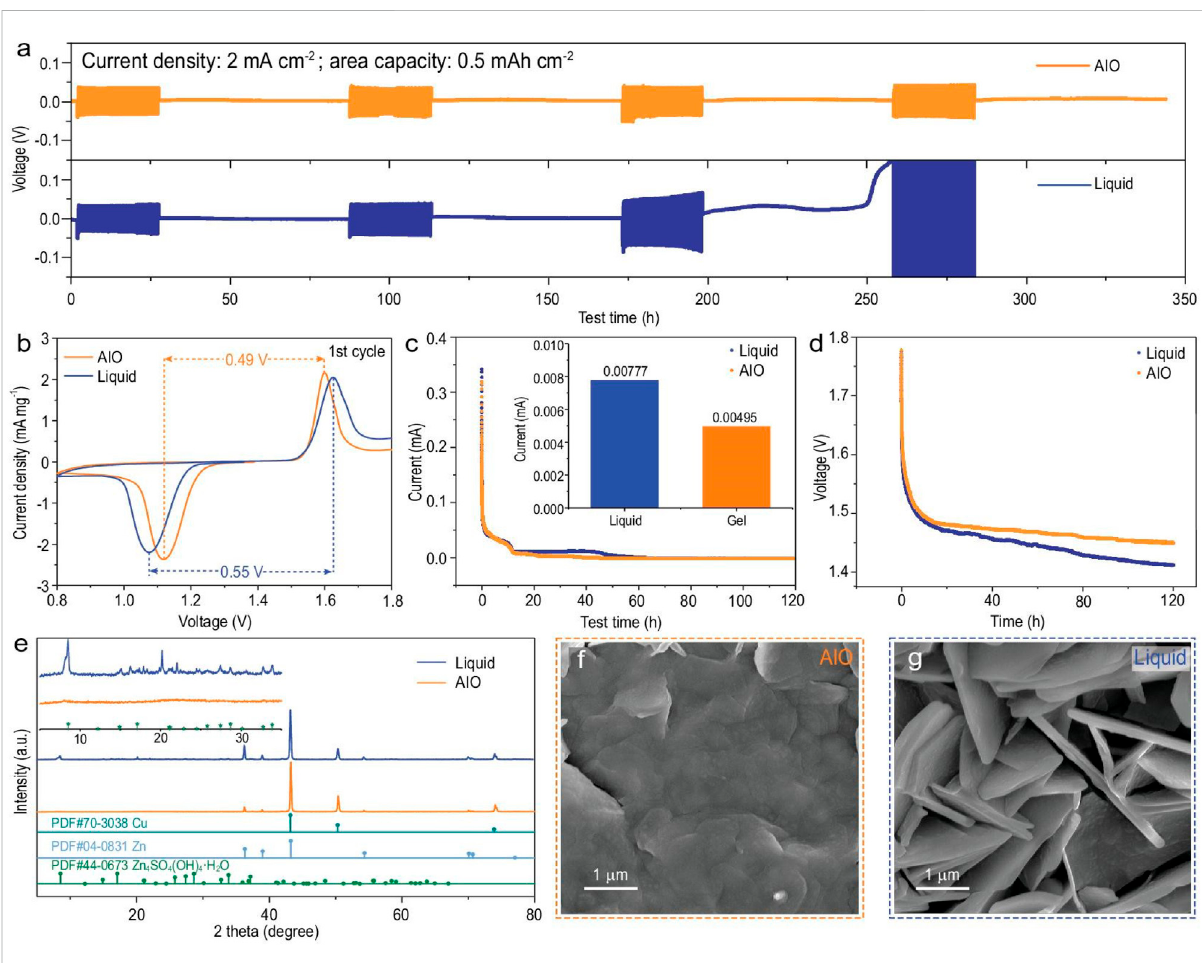
FIGURE 7 (A) Shelving-recoveryperformanceofCufoam@Zn/Cufoam@Znsymmetriccell(AIOelectrode/Cufoam@ZninAIOsystem)under2 mA · cm − 2 . (B) Firstcyclicvoltammetrycurve, (C) fl oatchargecurrent, (D) opencircuitpotentialdecaysofAIOelectrode/ α -MnO 2 andCufoam@Zn/ α -MnO 2 full cell. (E) XRD patterns of the anodes in different full cell systems after 100 cycles at 500 mA · g − 1 , and the corresponding SEM images of (F)